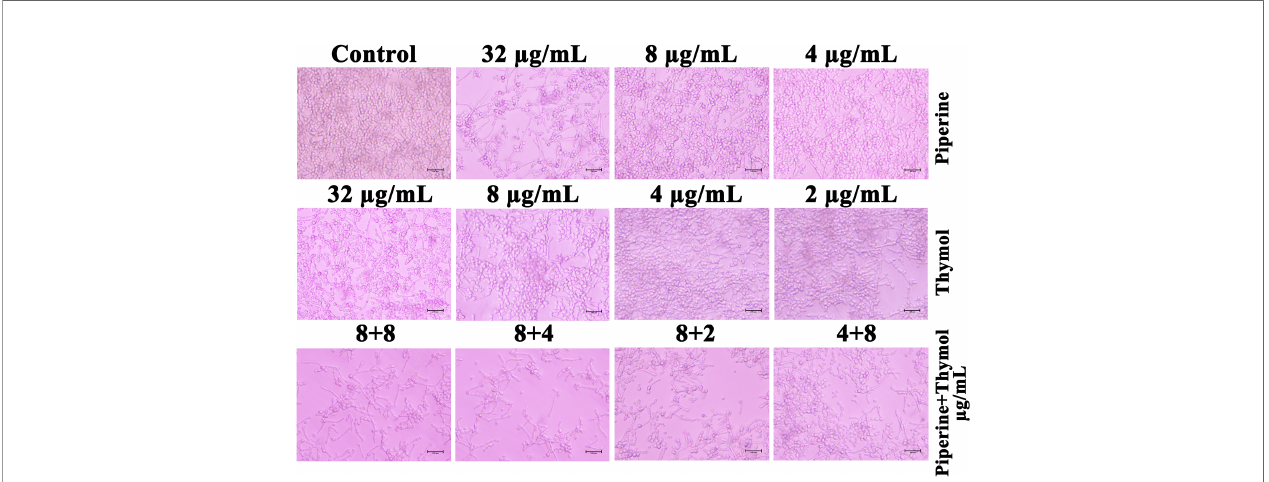
FIGURE 8 | Reversion of hyphal to yeast morphology. Synergistic combinations of piperine and thymol exhibited pro fi ciency in limiting and reverting the hyphal extension to yeast